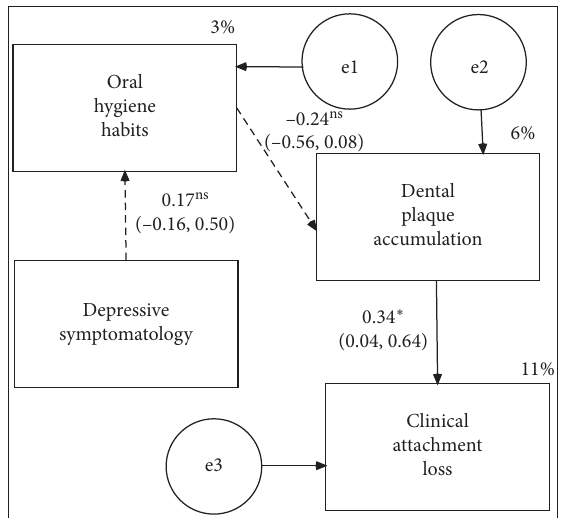
Figure 2: Maximum-likelihood parameter point estimates and 95% Monte Carlo confidence intervals (with 10,000 bootstrap samples) in the sample of 35 dental patients.